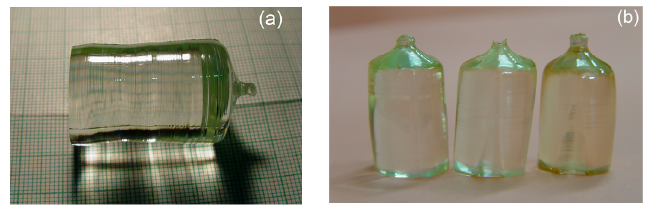
Figure 2. As-grown ( a ) undoped and ( b ) Mg (2, 4 and 6 mol % from left to right) doped congruent LiNbO 3 crystals.